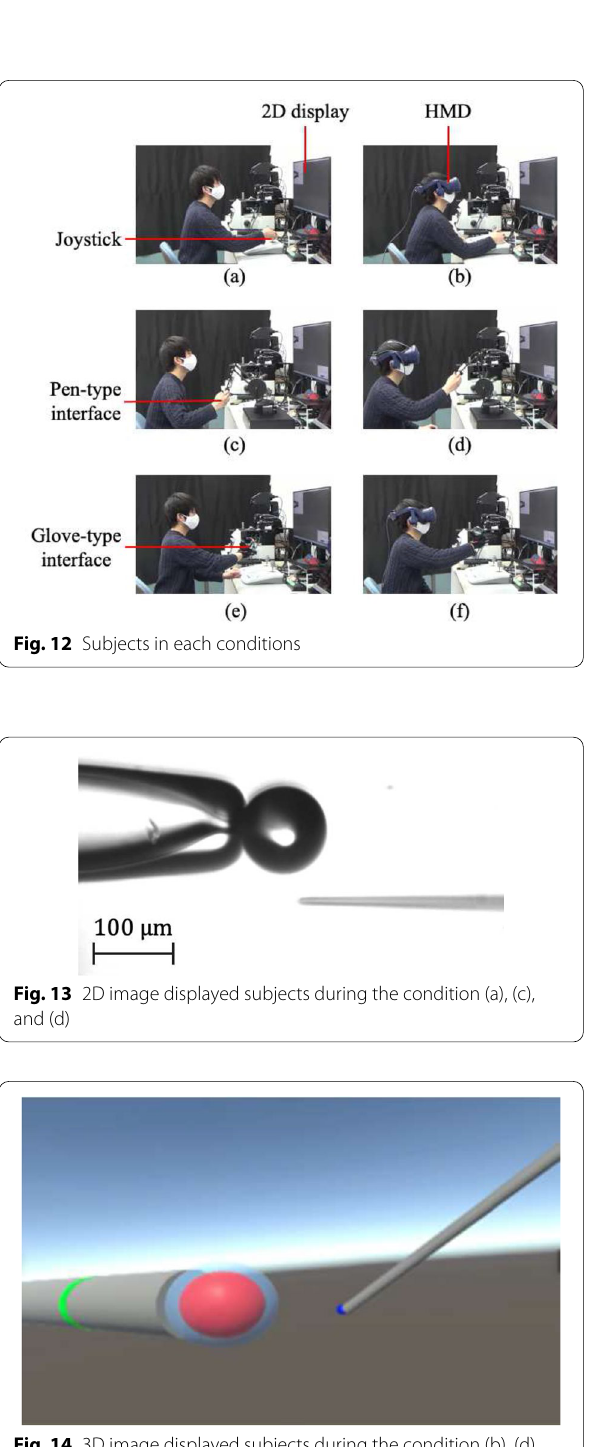
rank-sum test [20] on the number of laps for each subject between conditions (d) and (f).